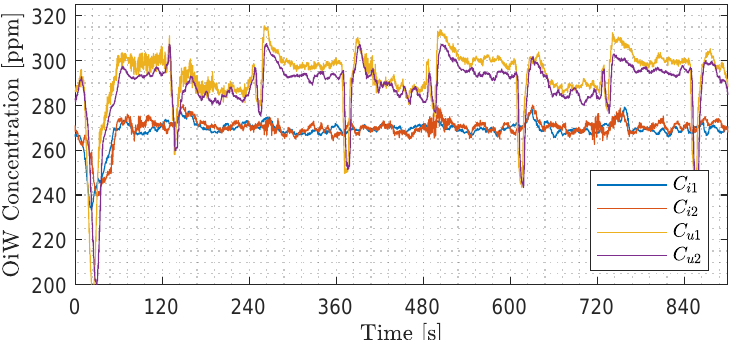
Figure 18. Mainstream flow toggling between hydrocyclone with closed overflow valve and direct pipe connecting the inlet to the underflow every 120 s, starting with the hydrocyclone with closed overflow from 0–120 s.